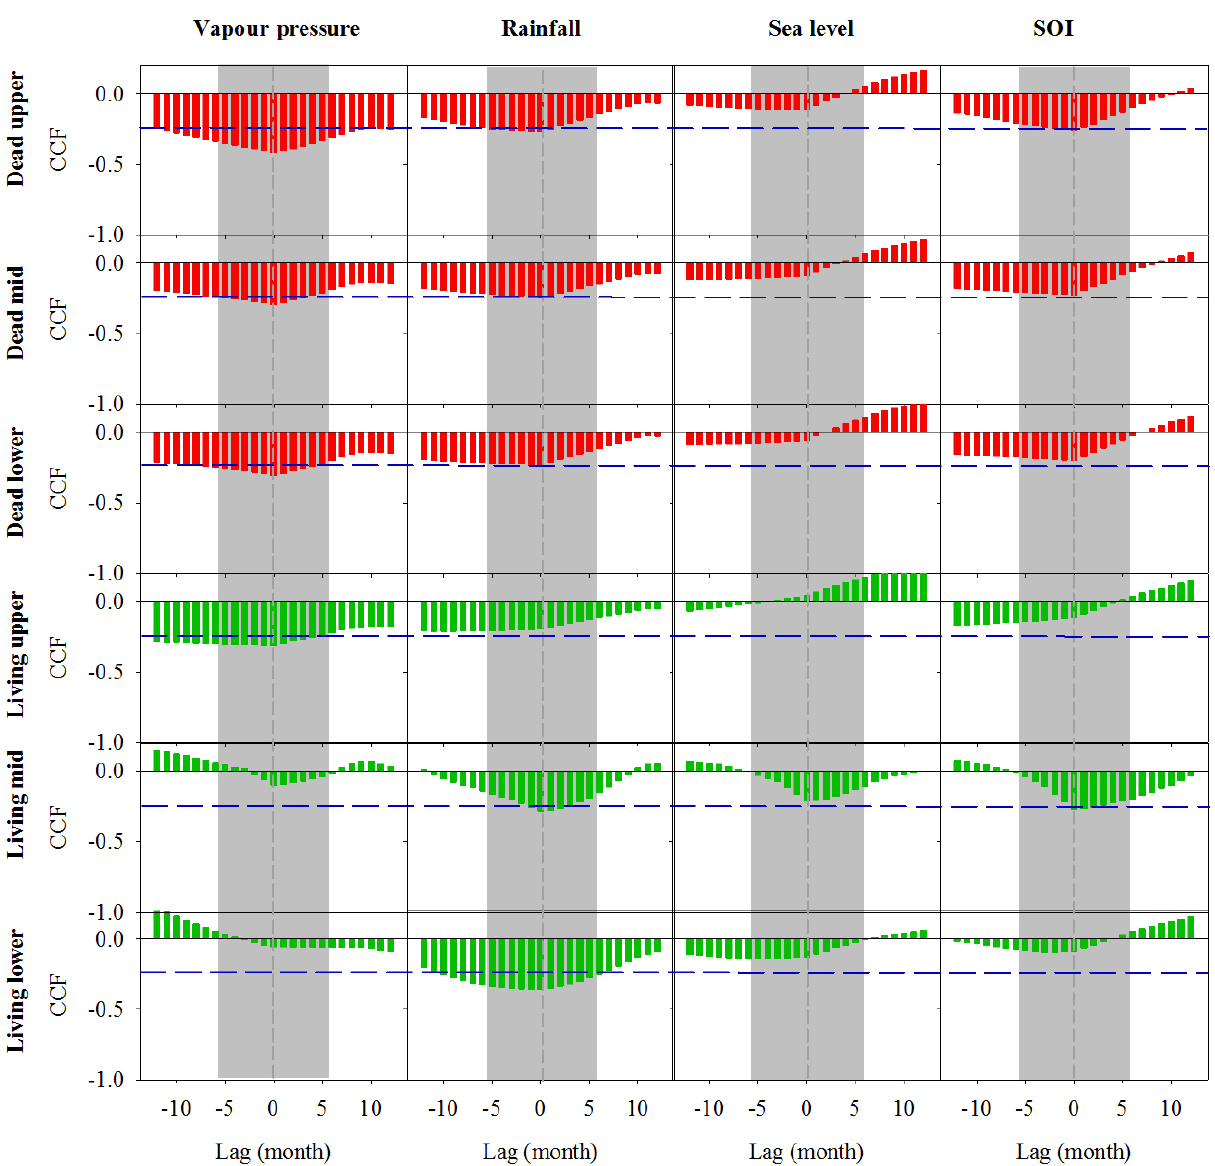
Figure 4. Cross-correlation function (CCF) between Fe in wood samples and climate data at a 1-month resolution over a 12-month period prior to and following dieback. Wood samples are from the upper, mid and lower intertidal zones of the dead (red) and living (green) mangrove areas. Blue horizontal dashed lines indicate P < 0 . 01 with n = 125. Grey dashed vertical lines at zero lag indicate the dieback period, and the grey bar represents the period during which the dieback event